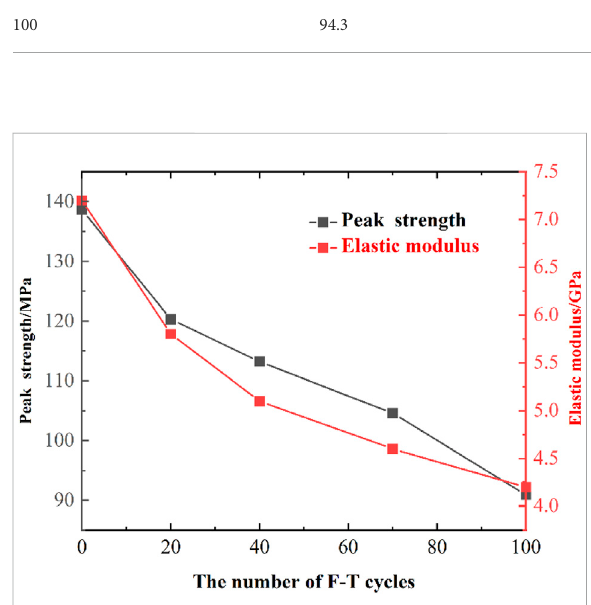
FIGURE 15 Peak strength and elastic modulus of granite under different numbers of F – T cycles.